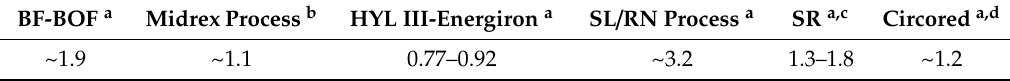
Table 2. CO 2 emissions from various steelmaking technologies in tons per ton of iron. BF-BOF a Midrex Process b HYL III-Energiron a SL / RN Process